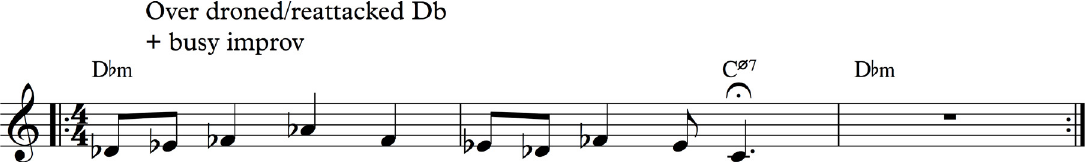
Figure 1. Melody transcribed from trio improvisation.